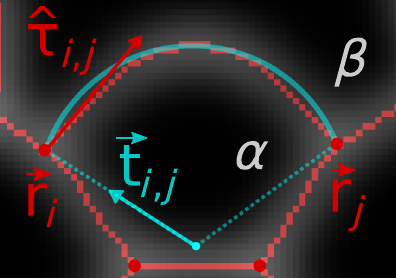
FIG. 7. An illustration of the definitions used in the procedure to find an initial estimate of f p α ; q α g , plotted on top of simulated data. The segmentation is shown in red while the idealized edge (to be fitted) is shown in light blue. The tangent vectors τ i;j are estimated from the segmentation. The minimization of E I [Eq. (C1)] finds f p α ; q α g minimizing the overlaps ˆ t j;i · ˆ τ j;i